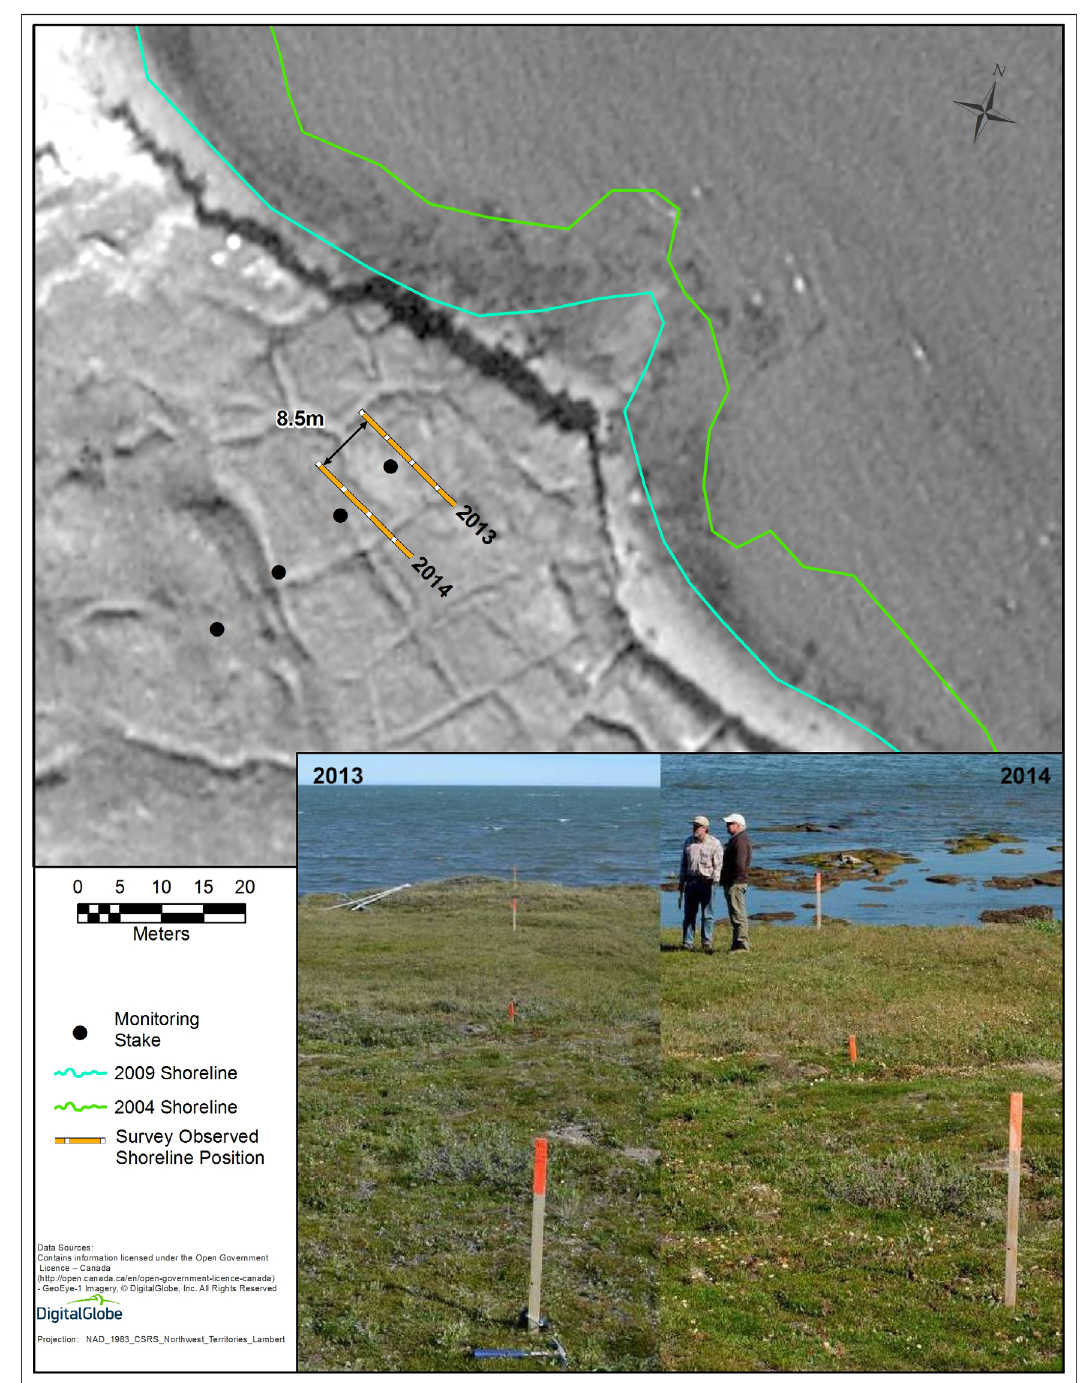
Fig. 8: Toker Point shoreline positions observed during 2013 and 2014 field